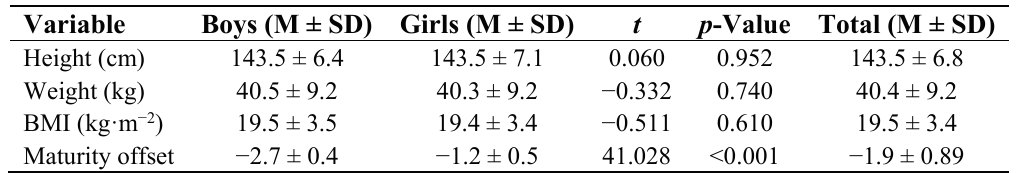
Table 1. Boys’ and girls’ descriptive statistics (means (M) ± standard deviations (SD)), t - and p -values for testing sex differences.